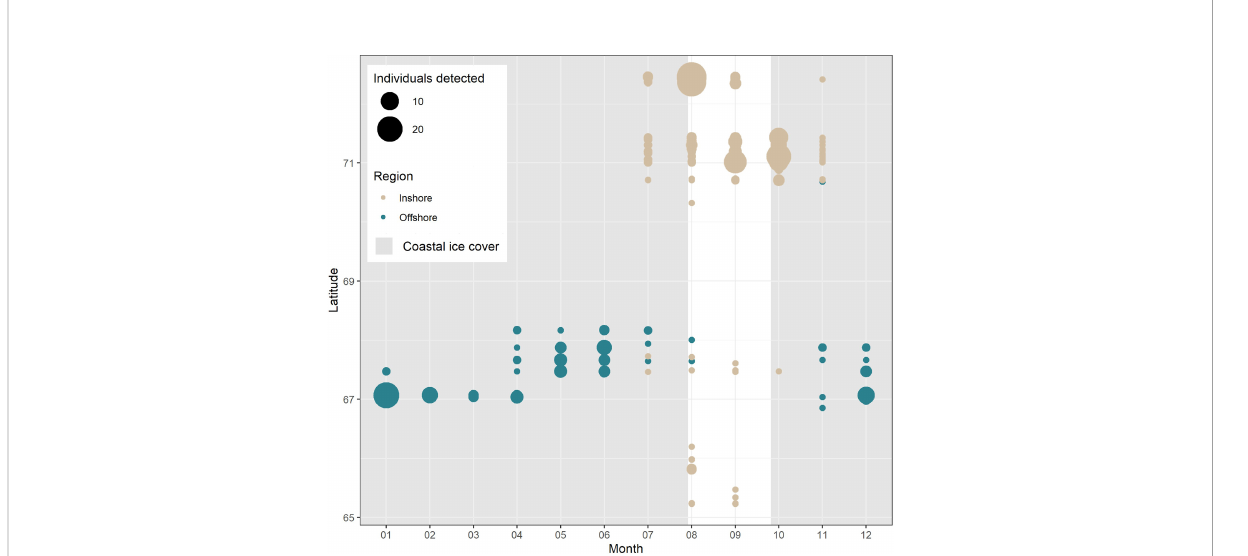
FIGURE 5 Greenland shark detections arranged by month and latitude. Points are scaled by the number of unique individuals recorded at each time and location and are coloured by the region in which the detections were recorded ( i.e. , inshore vs. offshore). Shaded bars denote the average annual period of ice cover between the timing of formation (>75% sustained cover) and breakup (<75% sustained cover) in Scott Inlet (Nunavut) throughout the study period (data available at: https://ice-glaces.ec.gc.ca/). [Colour